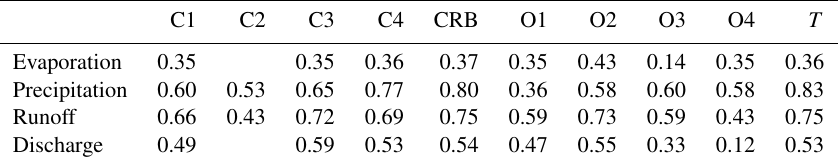
Table 3. Significant monthly correlation ( p< 0 . 05) between the precipitation from the CRU, runoff from ERA-Interim, river discharge from the GRDC and evaporation from GLEAM or OAFlux, and forward-integrated | ( E − P ) i 10 < 0 | series with FLEXPART from the sources over the CRB, with the total | ( E − P ) i 10 < 0 | amount ( T ). Period used: